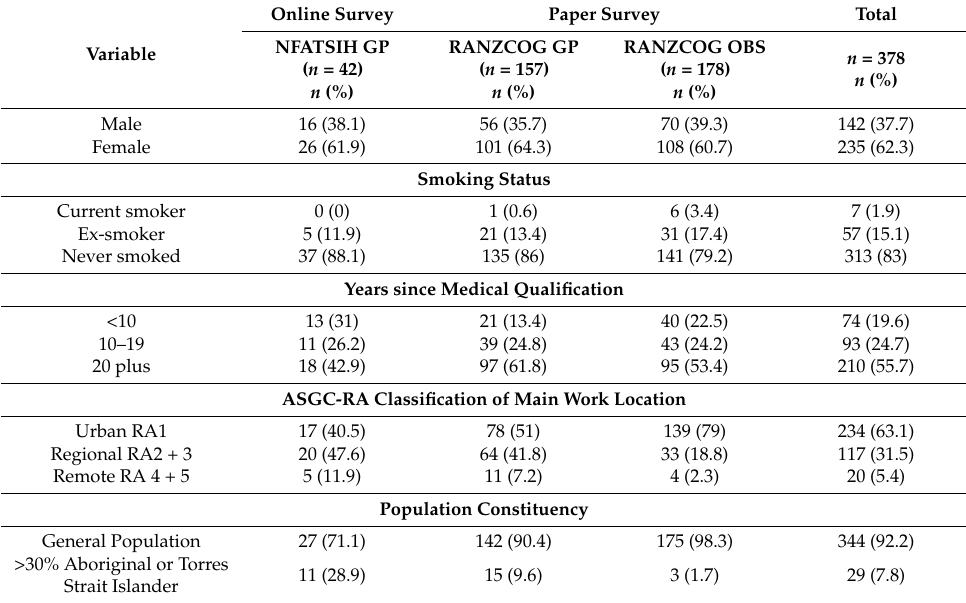
Table 1. Demographic characteristics of 378 Australian GP and Obstetrician respondents of a cross-sectional national survey.